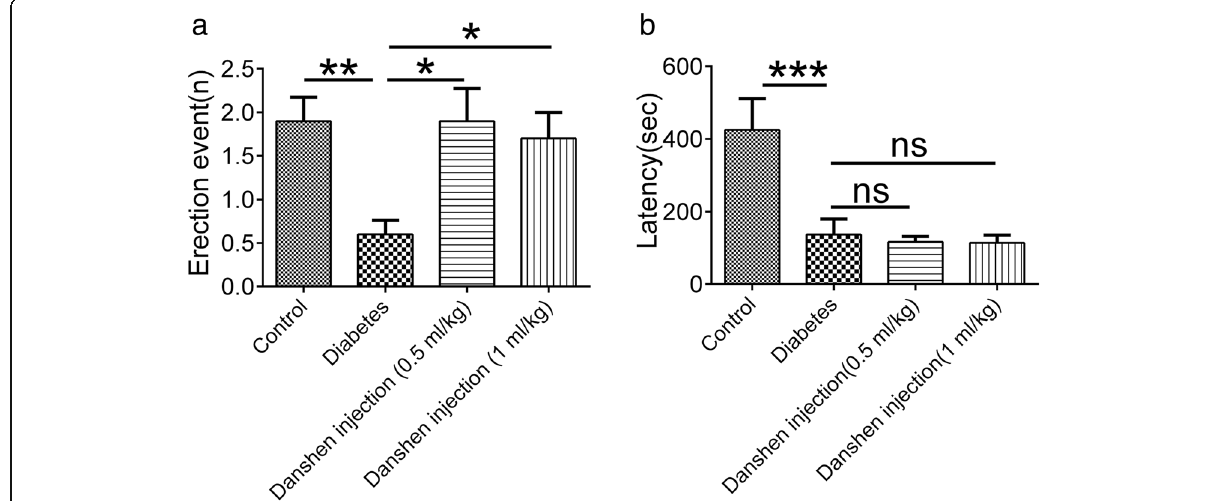
Fig. 2 Danshen injection alleviated erectile dysfunction in diabetic rats. Treatment with Danshen injection for 6 weeks could improve erectile function via increasing erection times ( a ) but could not prolong the erection duration ( b ). Data are presented as the mean ± standard error of the mean (S.E.M.) for ten rats per group. * P < 0.05; ns, not